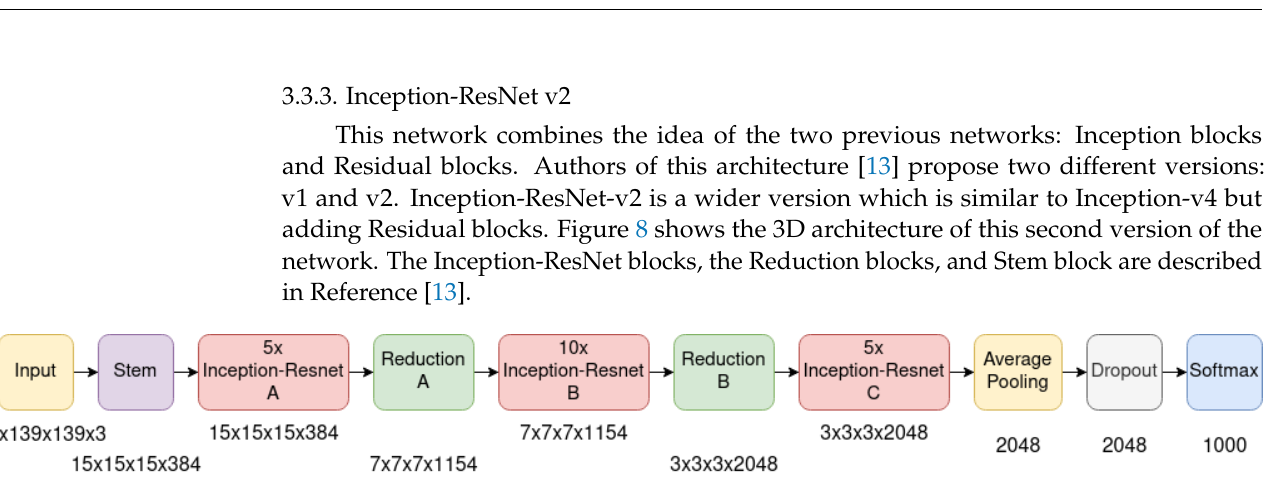
Figure 8. Inception-ResNet-v2